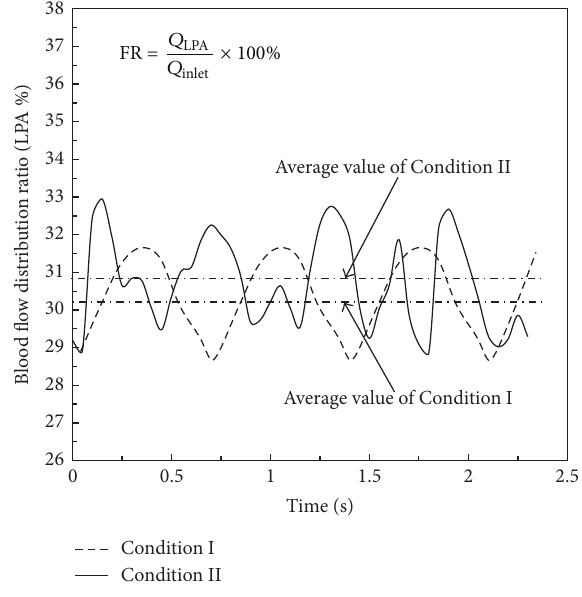
Figure 11: Results of flow distribution ratio at Condition I and ConditionIIatLPA(FR:flowdistributionratio;LPA:leftpulmonary